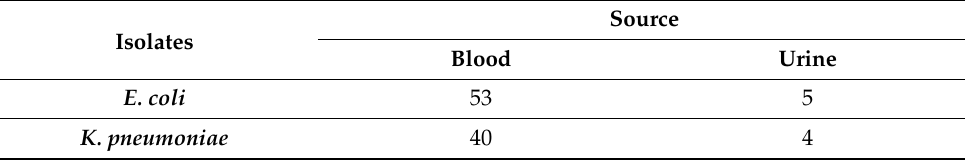
Table 1. An overview of the number of clinical isolates collected from Norwegian